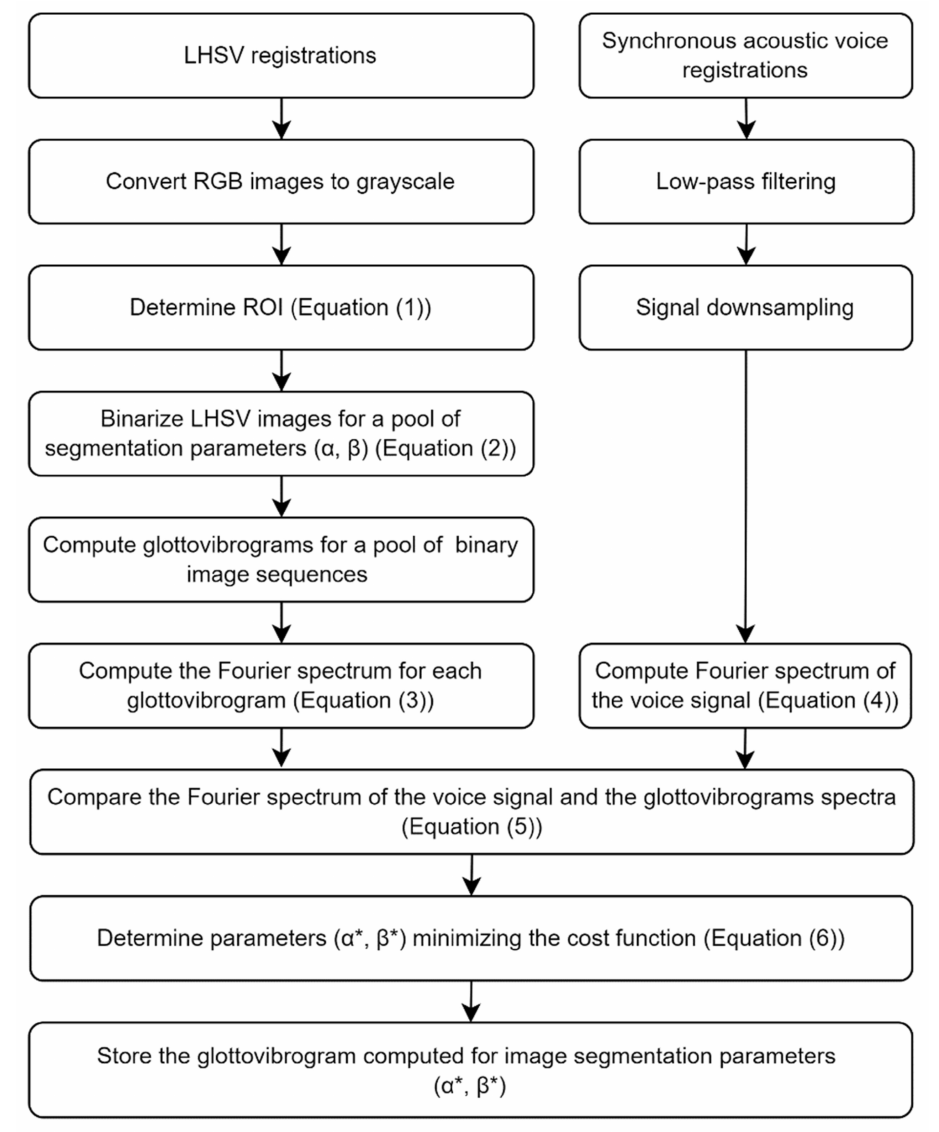
Figure 8. The processing pipeline of recorded LHSV images and synchronously recorded voice signal during sustained phonation of vowel